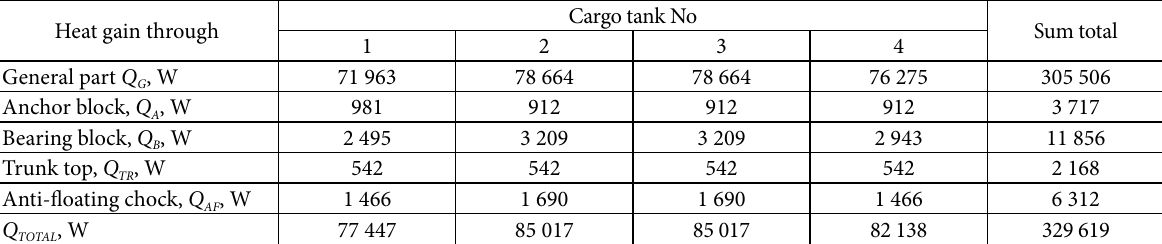
Table 1. Heat gain calculation